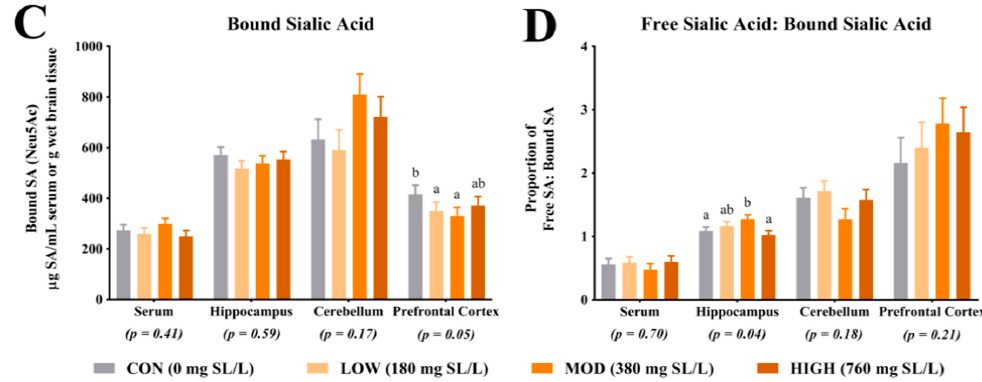
Figure 1. Bound sialic acid (SA) in the prefrontal cortex and the ratio of free SA to bound SA in the hippocampus are influenced by dietary sialyllactose (SL). ( A ) Dietary SL does not influence ( p > 0.05) total SA in serum, hippocampus, cerebellum and prefrontal cortex; ( B ) Dietary SL does not influence ( p > 0.05) free SA in serum, hippocampus, cerebellum and prefrontal cortex; ( C ) Dietary SL influences ( p = 0.05) the concentration of bound SA in the prefrontal cortex; ( D ) Dietary SL influences ( p = 0.04) the ratio of free SA to bound SA in the hippocampus. Note, serum SA concentrations are in µg/mL serum whereas brain tissue SA concentrations are in µg/g brain tissue.